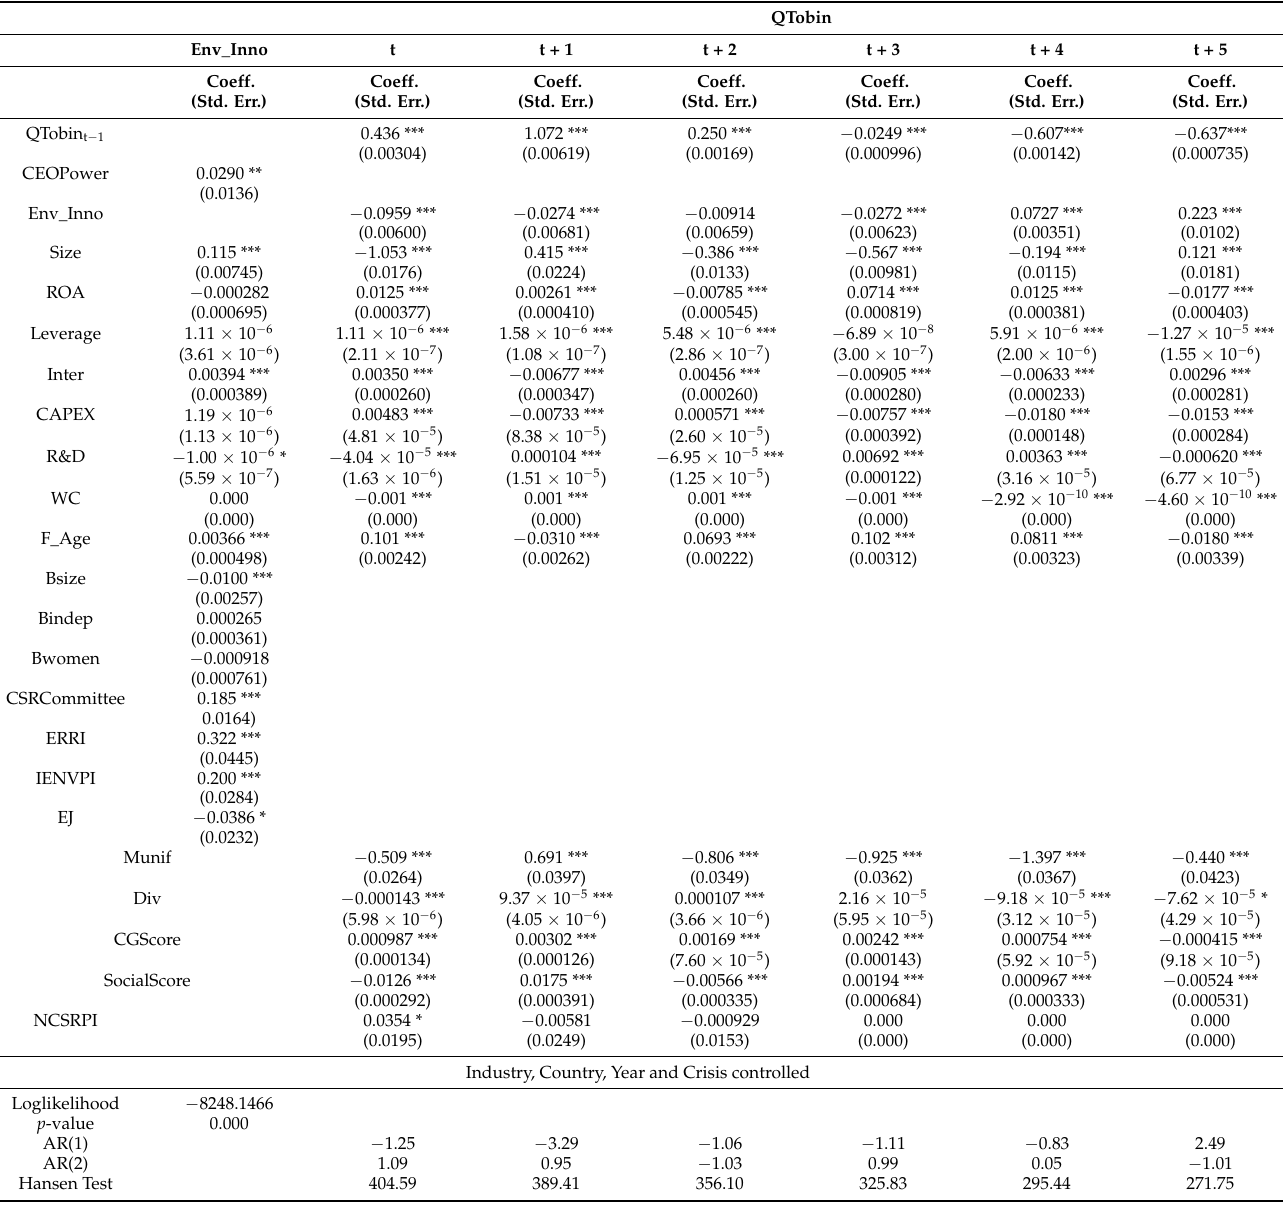
Table 3. Main results (*** p < 0.01, ** p < 0.05, * p <